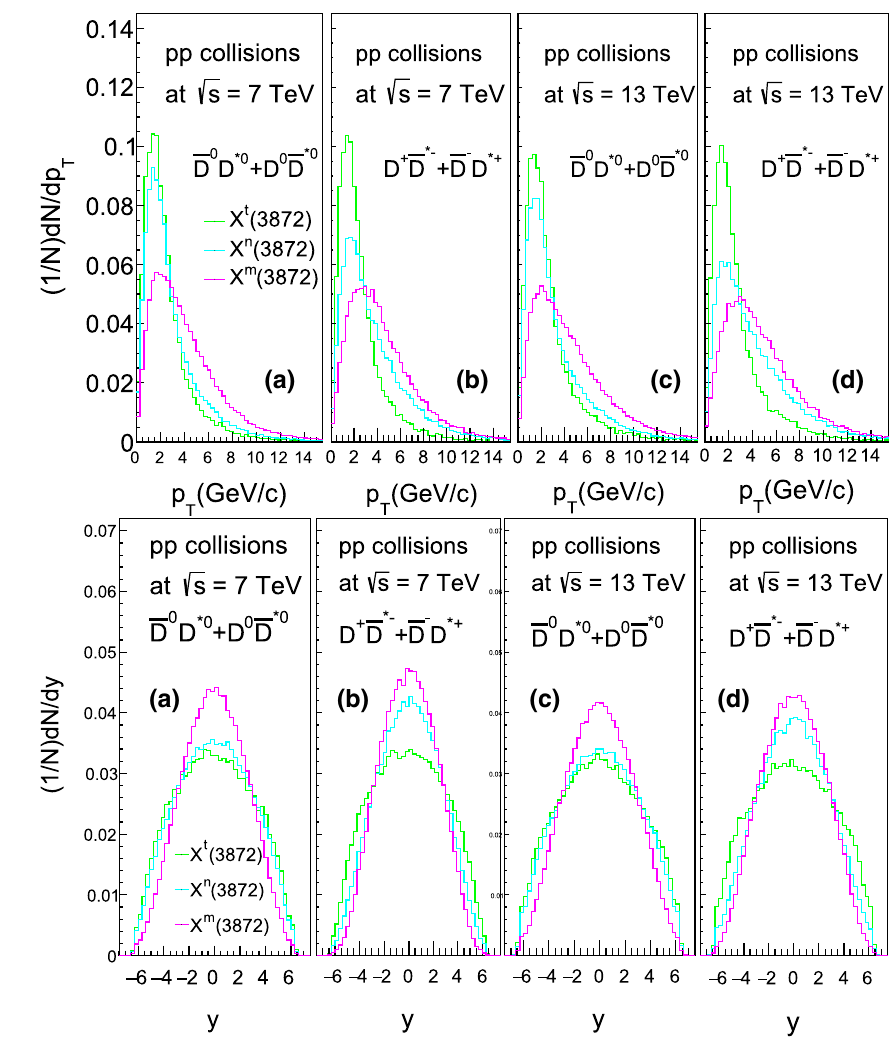
Fig. 2 Transverse momentum distributions of X ( 3872 ) of different structures produced for different D ¯ D ∗ clusters in pp √ s = 7, 13 TeV collision at with | y | < 1, 0 < p T < 15 . 5